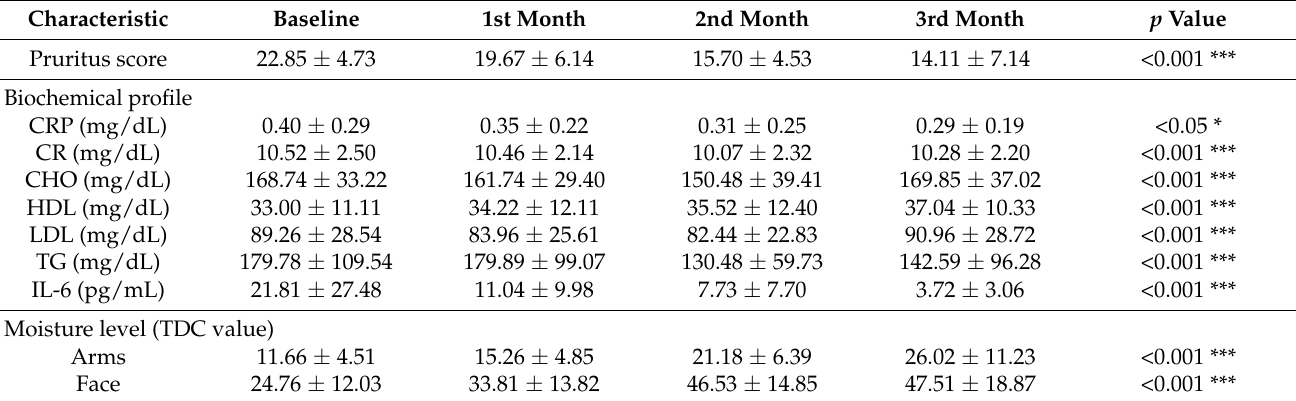
Table 3. Comparisons of Pruritus scores, biochemical profiles, and moisture levels before and after daily EPA supplementation in hemodialysis patients (mean ± SD).